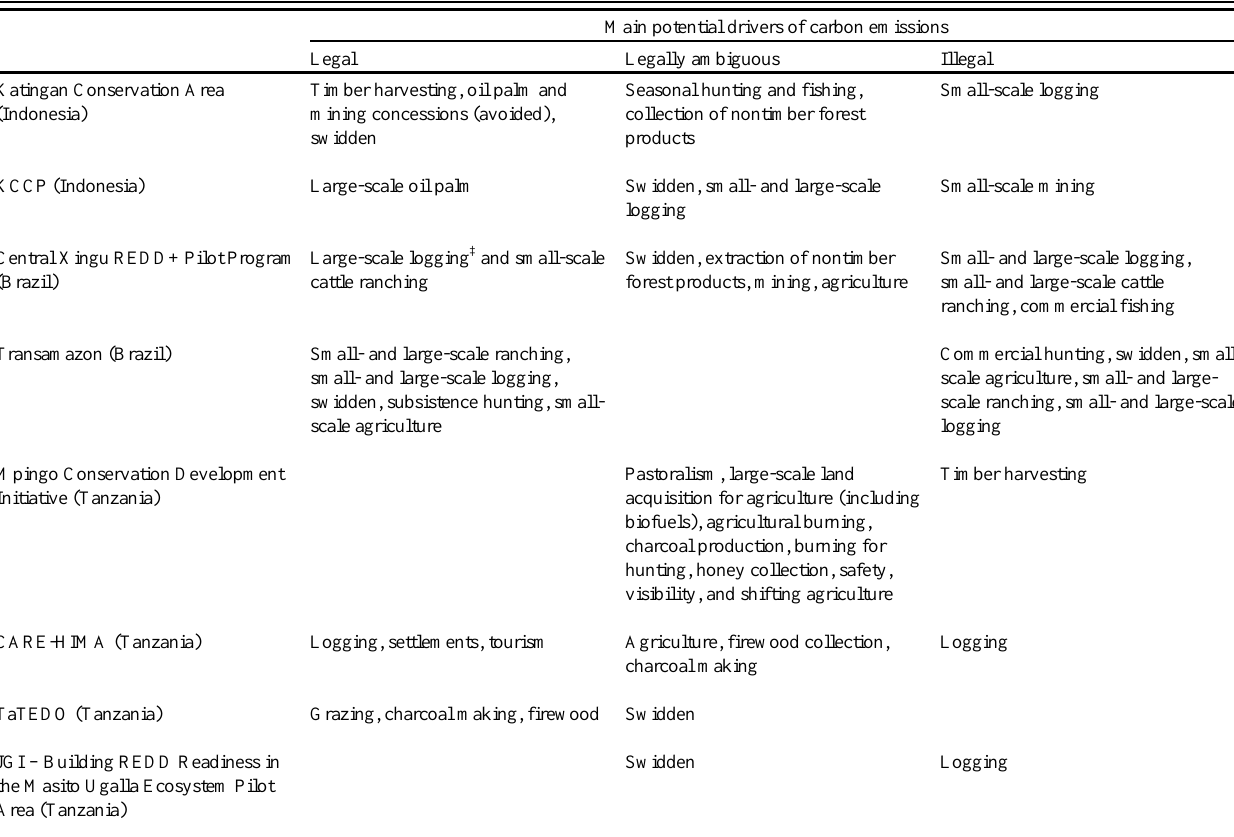
Table 5 . Legal status of land uses associated with carbon emissions in eight REDD+ projects, indicating potential equity problems arising from basing benefit sharing on a “legal rights” rationale. Projects were selected for this table to reflect a range of land use activities.